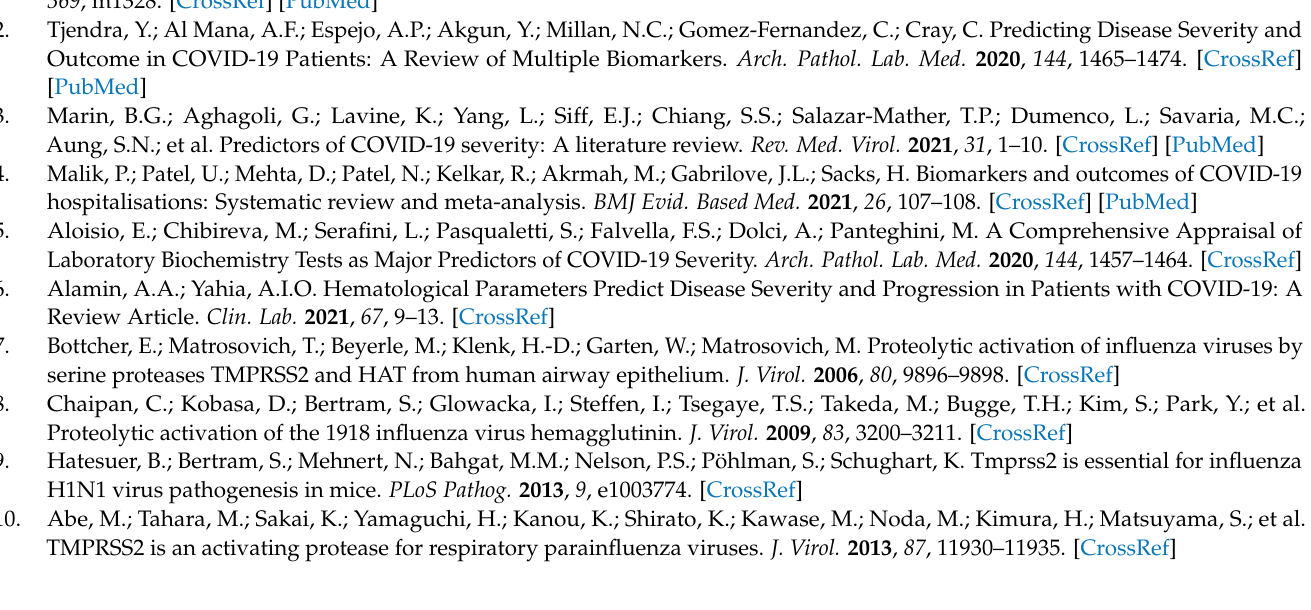
outcomes in COVID-19 patients who required mechanical ventilation compared to those who did not; Table S3: Laboratory results in COVID-19 patients who required mechanical ventilation and those who did not; Table S4: Correlations between ACE2 and other biomarkers associated with disease severity in COVID-19; Table S5: TMPRSS2 at an early disease stage is not an independent predictor of mechanical ventilation in COVID-19; Table S6: ACE2 and TMPRSS2 serum levels late in the disease course in COVID-19 patients; Table S7: ACE2/TMPRSS2 ratio does not predict the risk for mechanical ventilation in COVID-19